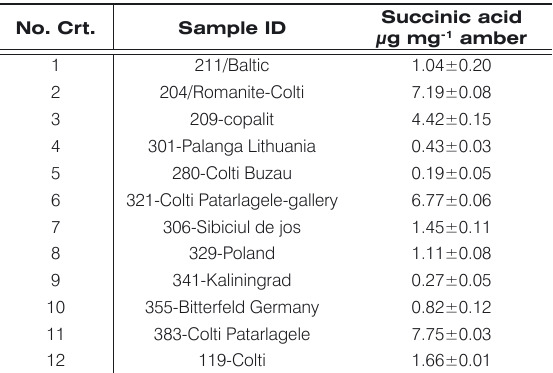
Table 1. Composition in succinic acid obtained by LC-MS from samples with controlled origin (Baltic amber and Romanite). No.